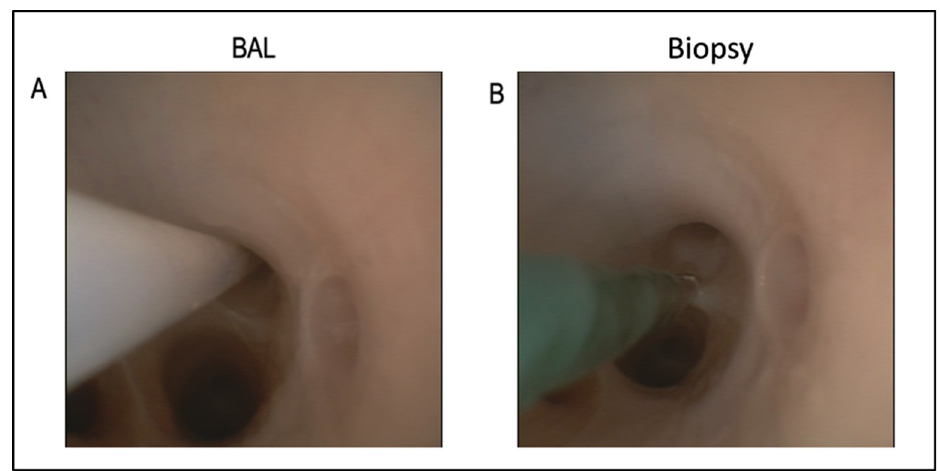
Fig 2. A and B: Target areas for broncho-alveolar lavage (A) and biopsies